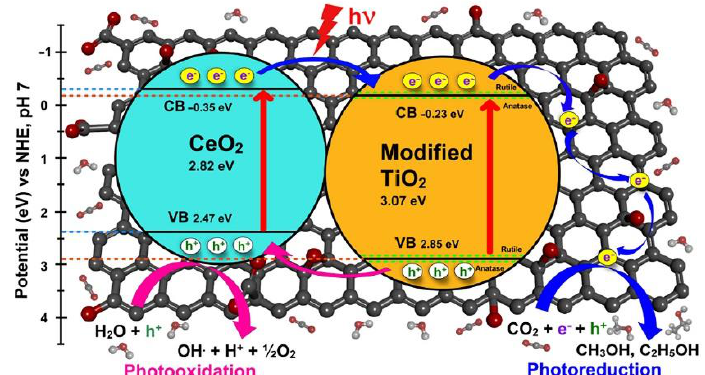
Figure 4. Proposed mechanism for photocatalytic CO 2 reduction to methanol and ethanol over a TiO 2 /rGO/CeO 2 catalyst. Reproduced with permission from reference